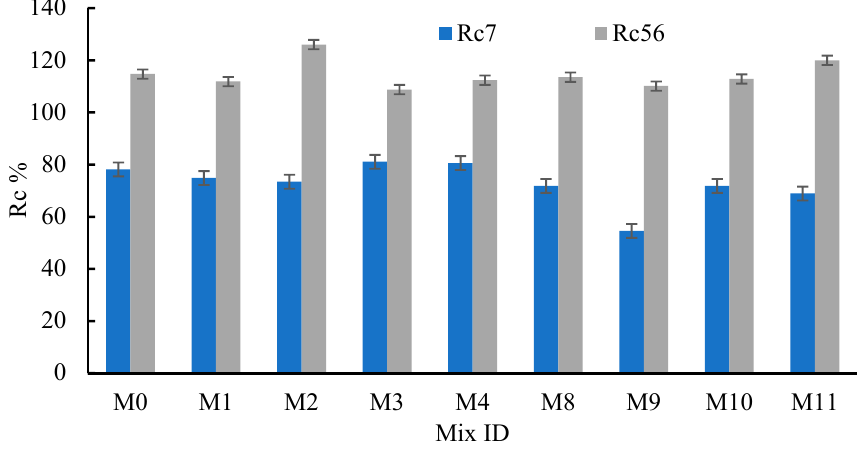
Figure 6. Effect of the RFNA and RFNA on Rc7 and Rc56.